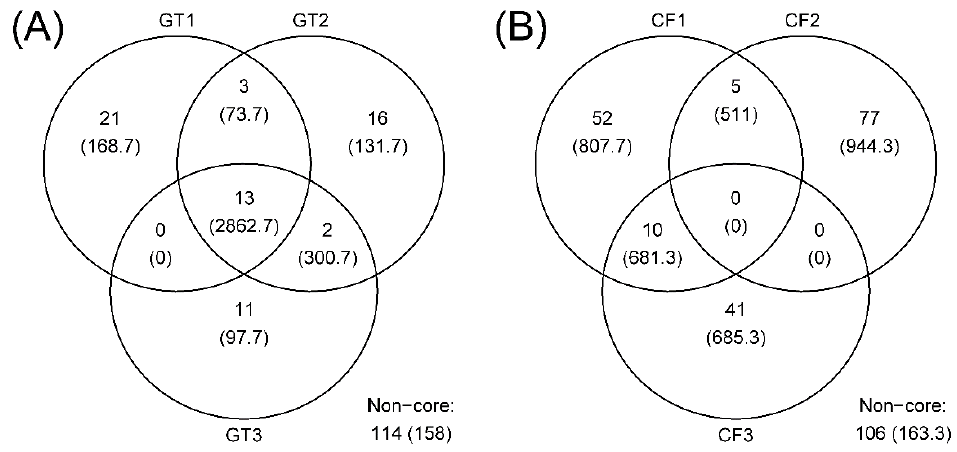
Figure 4. Venn diagrams showing the number of ASVs and their average abundance (the number of reads) in each chironomid species. (A) GT: G. tokunagai ; (B) CF: C. flaviplumus.